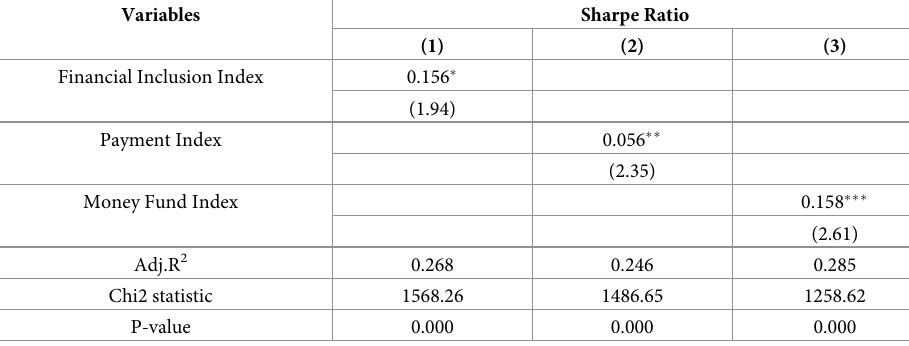
Table 2. Impact of financial inclusion development on household Sharpe